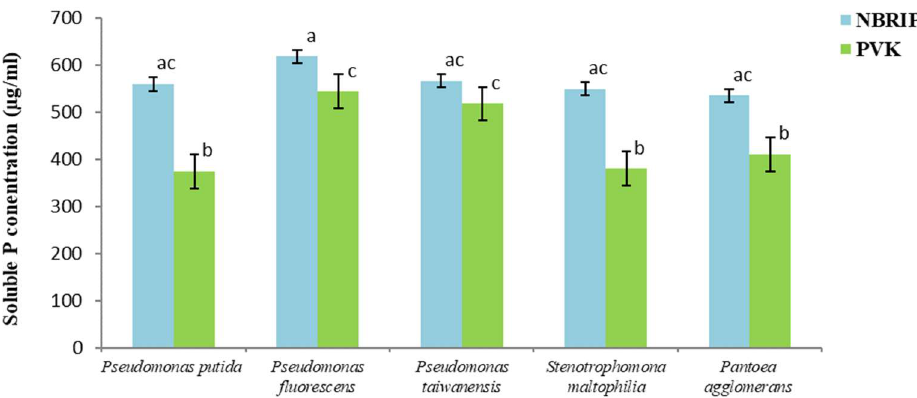
Figure 3. Phosphate solubilization by bacterial isolates grown in NBRIP and PVK media at 28 ± 2 ◦ C. Vertical bars represent confidence intervals at a confidence level of 95% (n = 3). Same letters indicate that differences among the means is not statistically significant (Tukey’s HSD post hoc test).